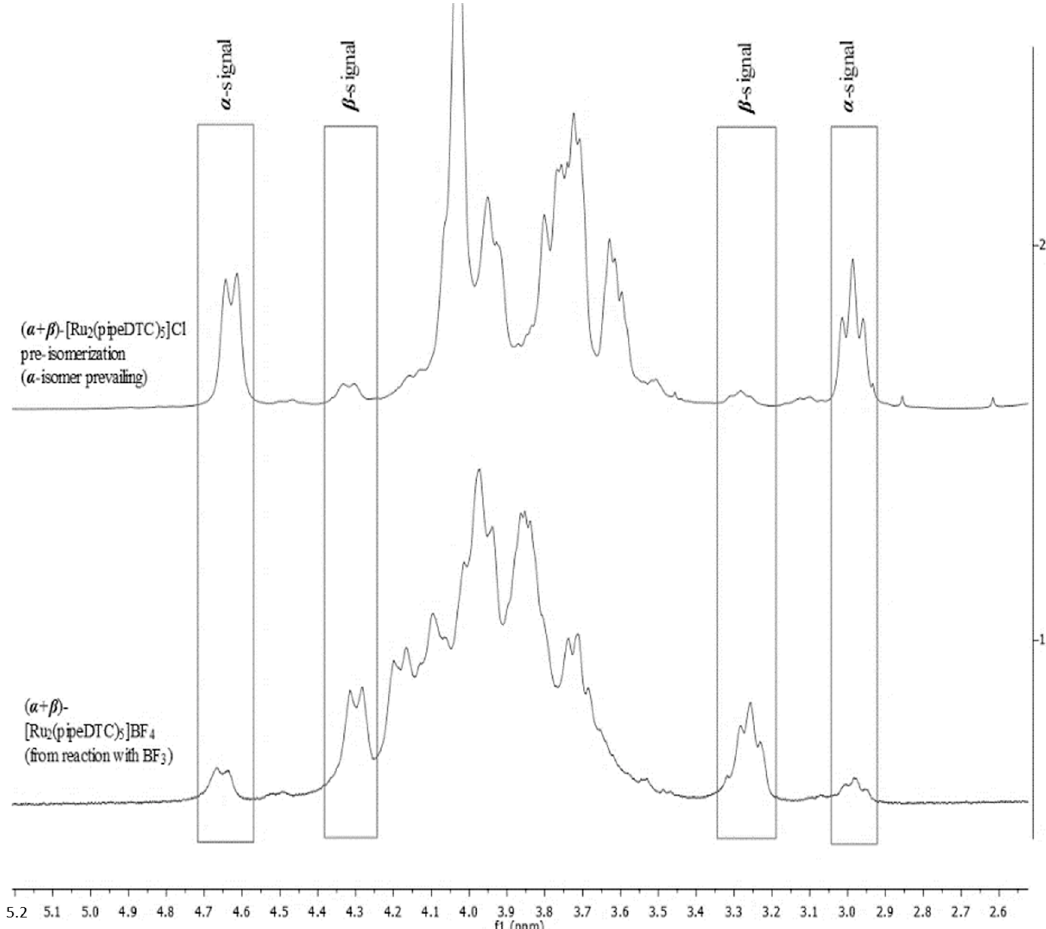
Figure 5. Analysis of two 1 H-NMR (600 MHz; CDCl 3 ) spectra of [Ru 2 (pipeDTC) 5 ]Cl ( above ) and [Ru 2 (pipeDTC) 5 ]BF 4 ( below ) allowed for the identification of peaks diagnostic for the α and the β